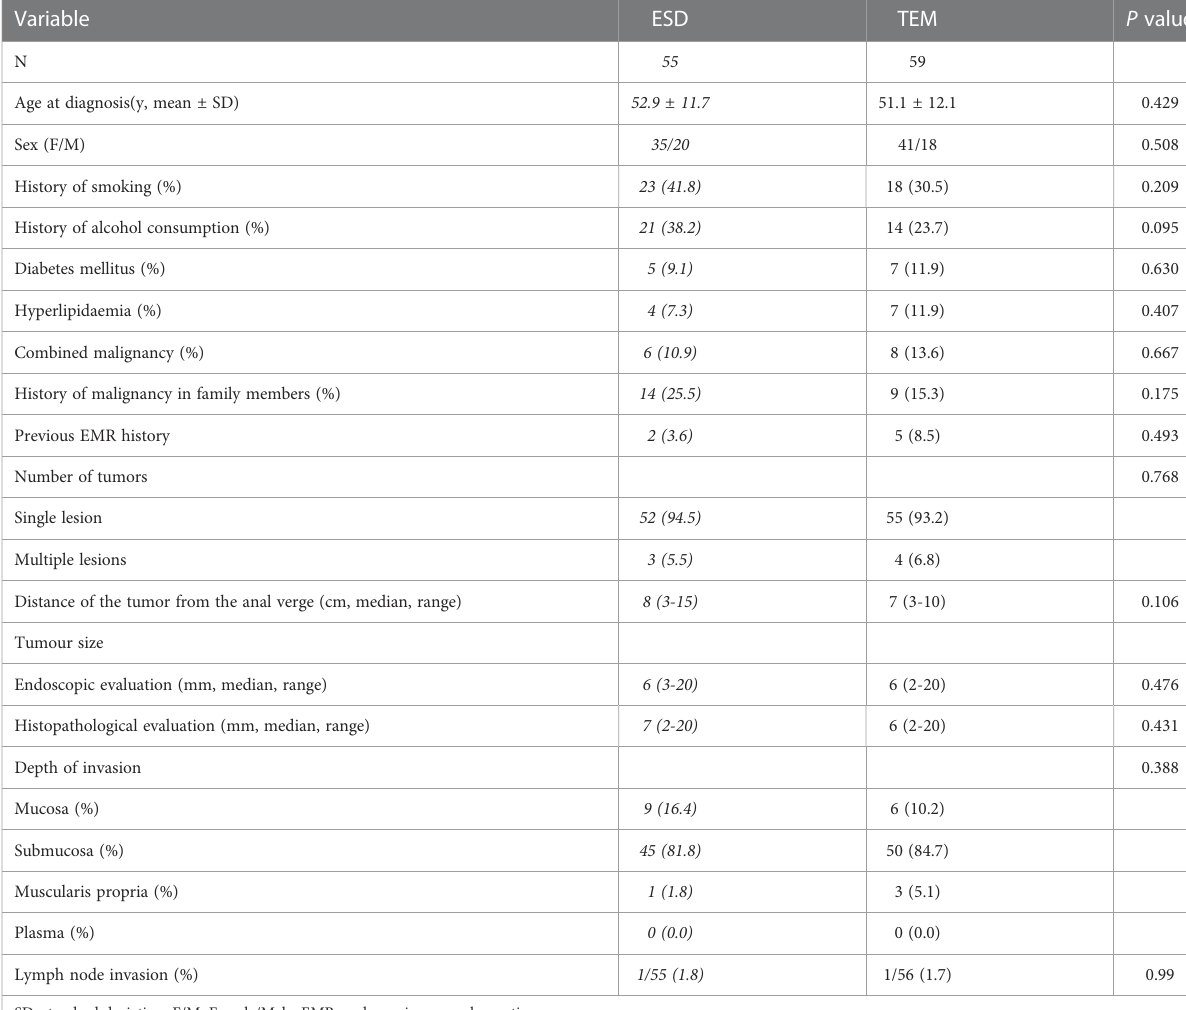
TABLE 1 Patients baseline data and characteristics of tumors.